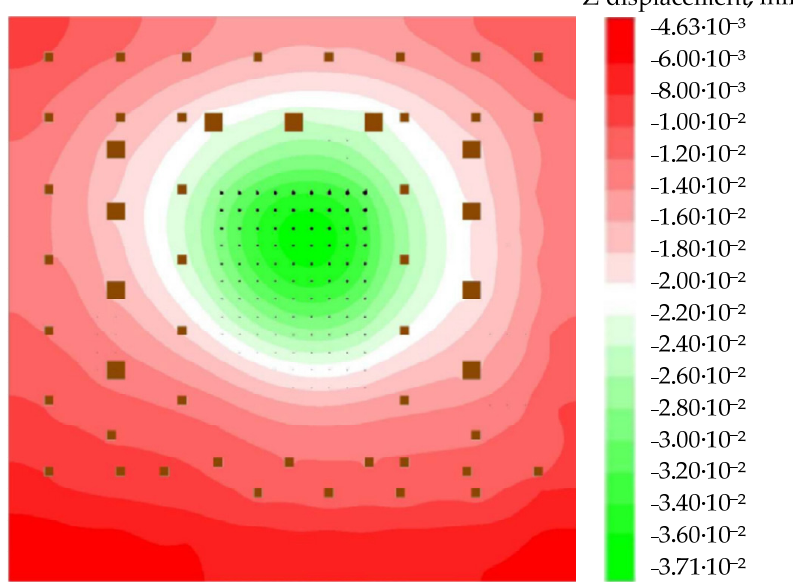
Figure 2. Deformation contour plan of raft foundation according to Zhussupbekov et al. [2] simulation results with FLAC 3D program.